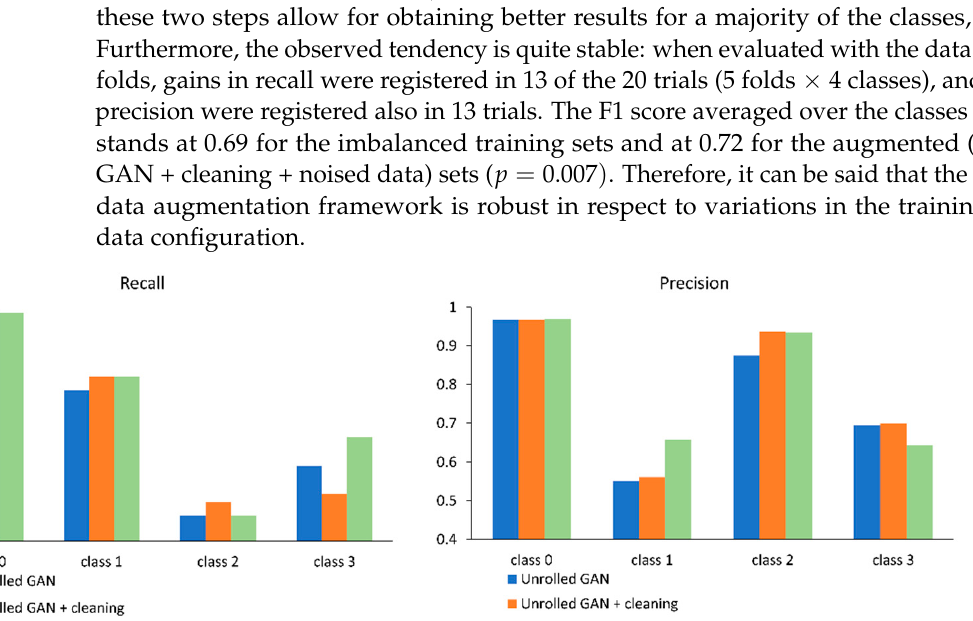
signal pattern corresponding to a speed bump is highlighted) and ( b ) prematurely generated.